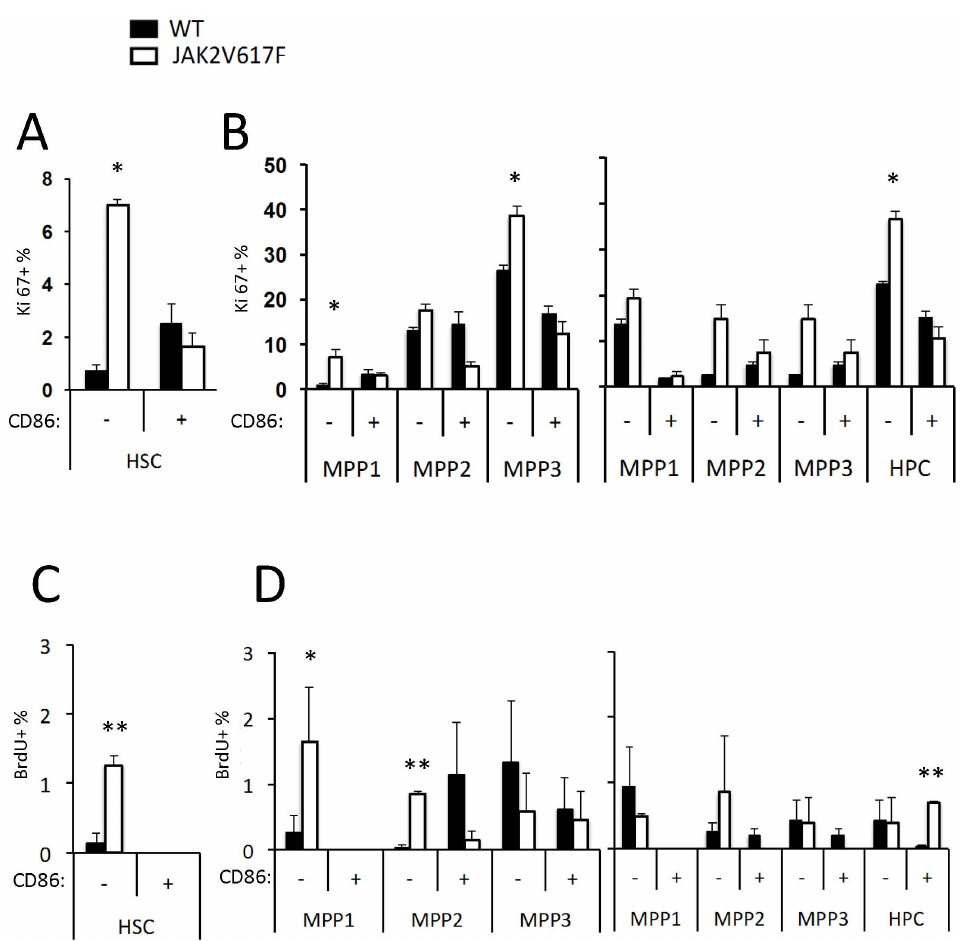
Figure 6. The JAK2V617F transgene may slightly alter proliferation of stem/progenitor cells. The CD150 + CD48 2 HSC ( A ) and the multipotent progenitors ( B ) described Fig. 4 were stained with the proliferation associated Ki67 marker. Percentages of Ki67 + cells in BM were calculated. As another approach, the same marrow samples were pulsed with BrdU in very short-term cultures before staining ( C, D ) . These results are given as percentages of BrdU + cells per subset and significance is indicated by asterisks p , 0.01(**), p , 0.05(*). These data were obtained in a single experiment (N=3).